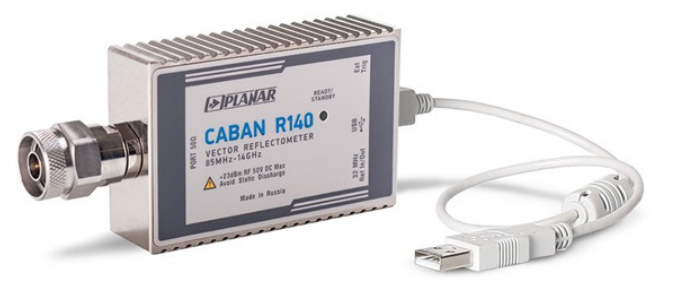
Figure 8. Vector reflectometer CABAN R140.